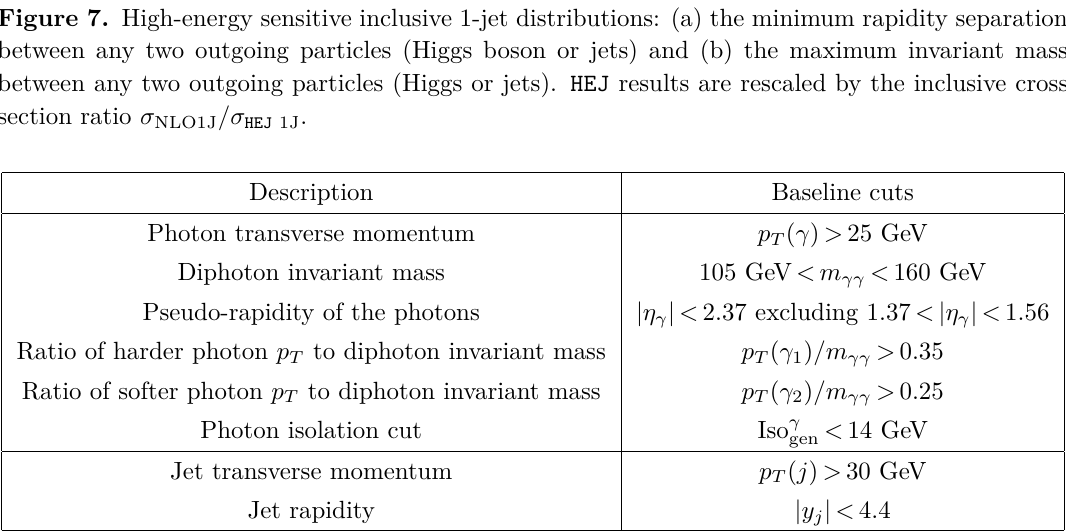
Table 4. Baseline cuts of the 8 TeV analysis, following the ATLAS analysis of [33]. Iso γ